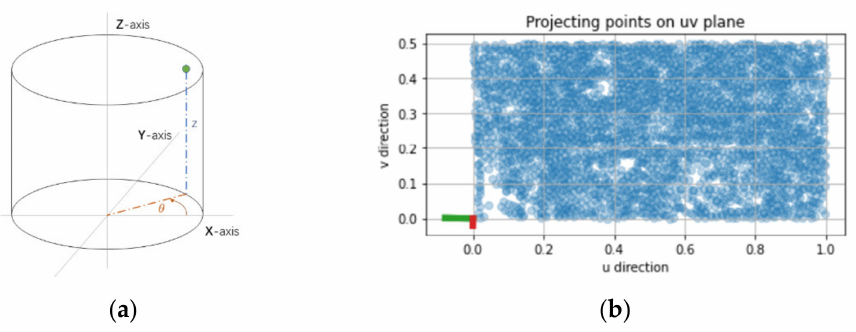
Figure 5. ( a ) Cylinder in the cylindrical coordinate system; ( b ) parameterizing point cloud of cylinder